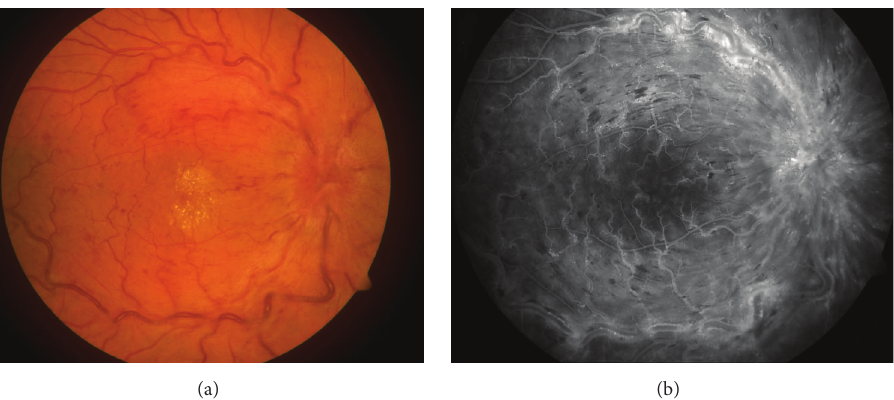
Figure1:(a)Fundusretinographyoftherighteye(CanonCX-1,Canada):diffuseretinalandopticdiscedema,venousdilation,andtortuosity; (b) intravenous fluorescein angiography showing nonischemic central retinal vein occlusion. Hemorrhagic blockage, venous tortuosity, and dilation, along with leakage from the optic disc and macula, are